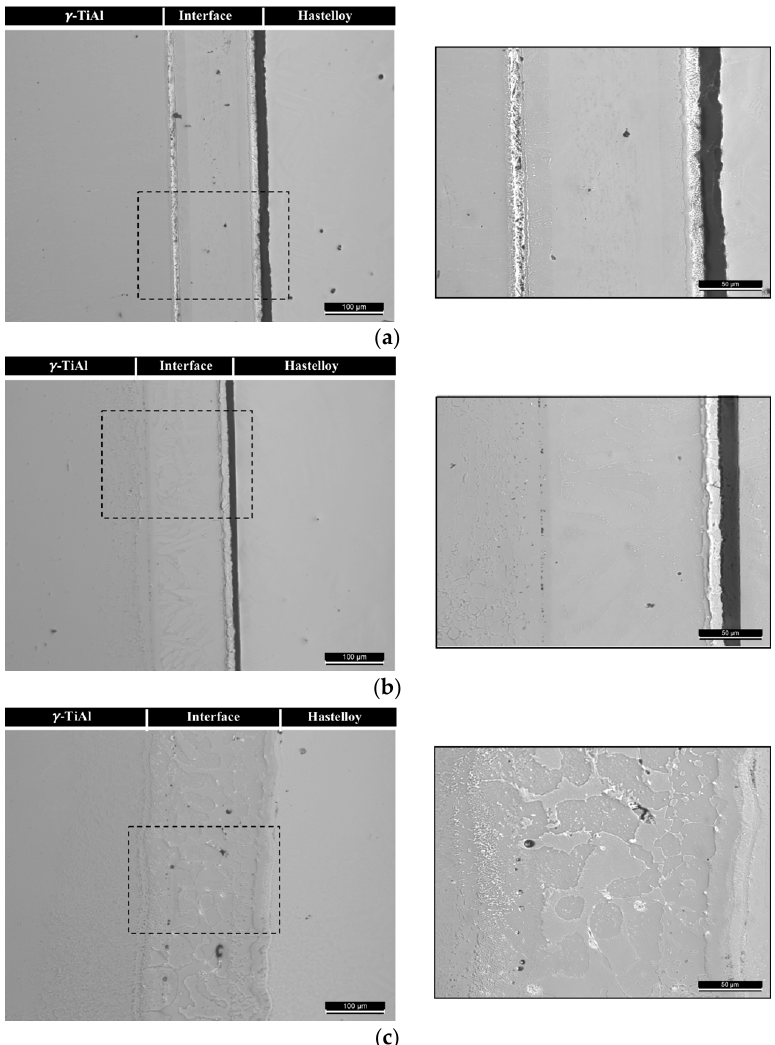
Figure 4. Optical microscopy (OM) images of the joint interfaces obtained at ( a ) 900 °C, ( b ) 950 °C, and ( c ) 980 °C.